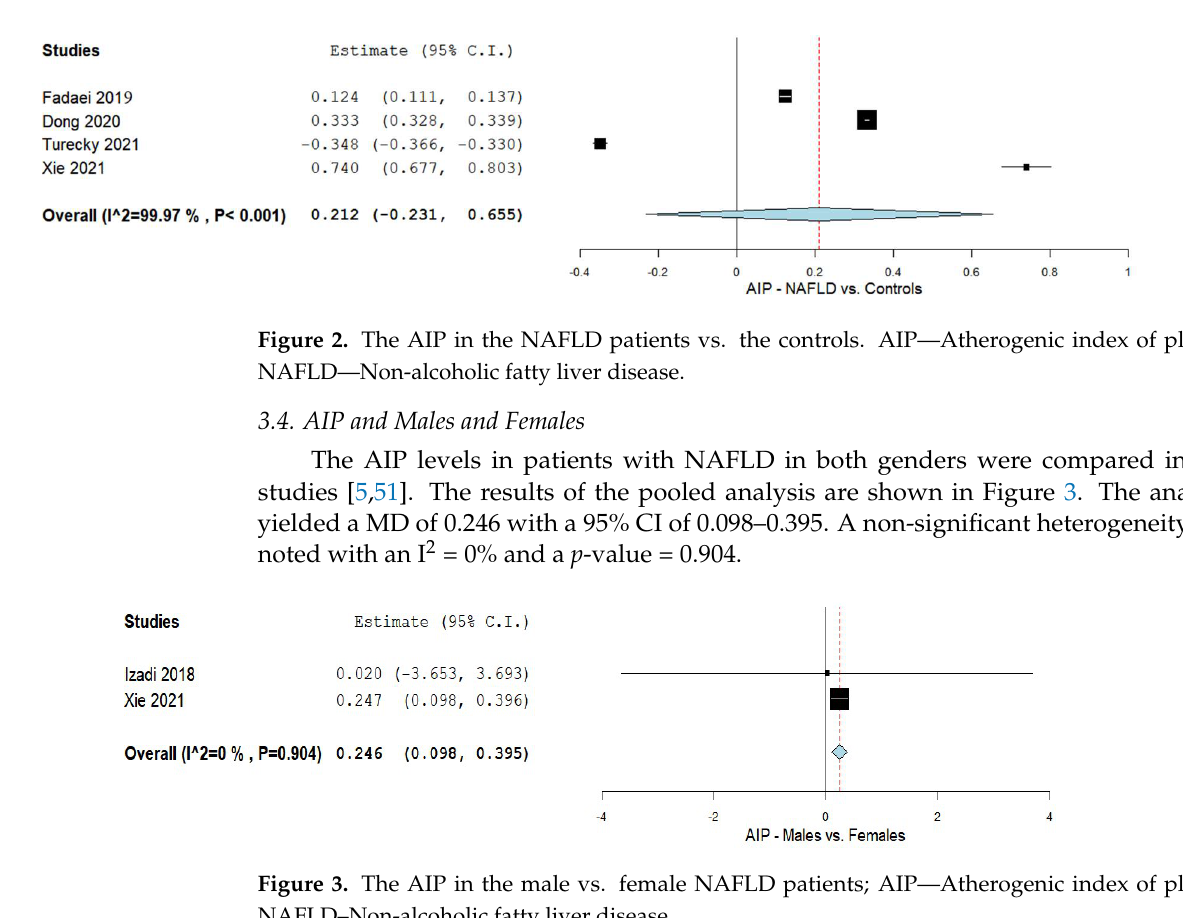
Figure 2. The AIP in the NAFLD patients vs. the controls. AIP—Atherogenic index of plasma; NAFLD—Non-alcoholic fatty liver disease.